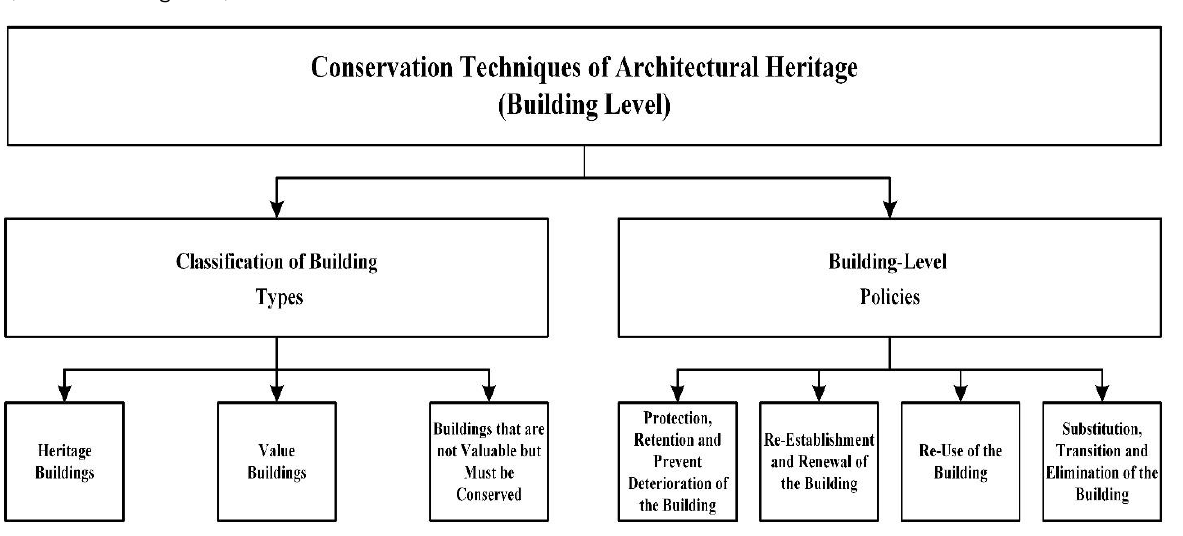
Figure 1: The conservation techniques of architectural heritage – building level